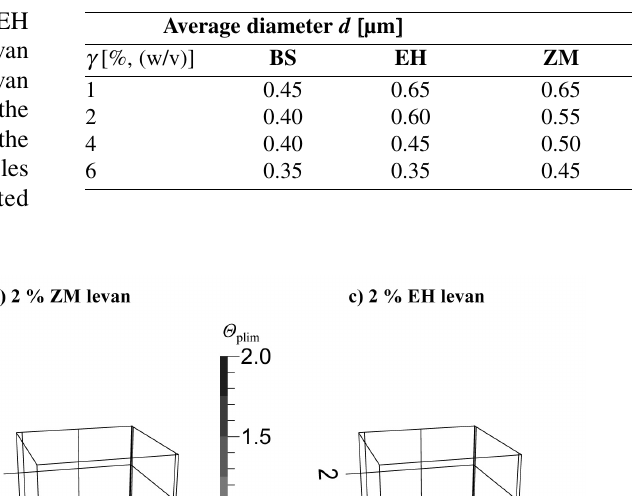
= 1.75, Θ = 0.9, Φ = 1.241, and p * = 0.35), b) 2 wt % ZM levan ( Θ plim p p = 2, Θ = 1.05, Φ = 1.246, and p * = 0.225). Above: Resulting shape parameters are pre- plim p p